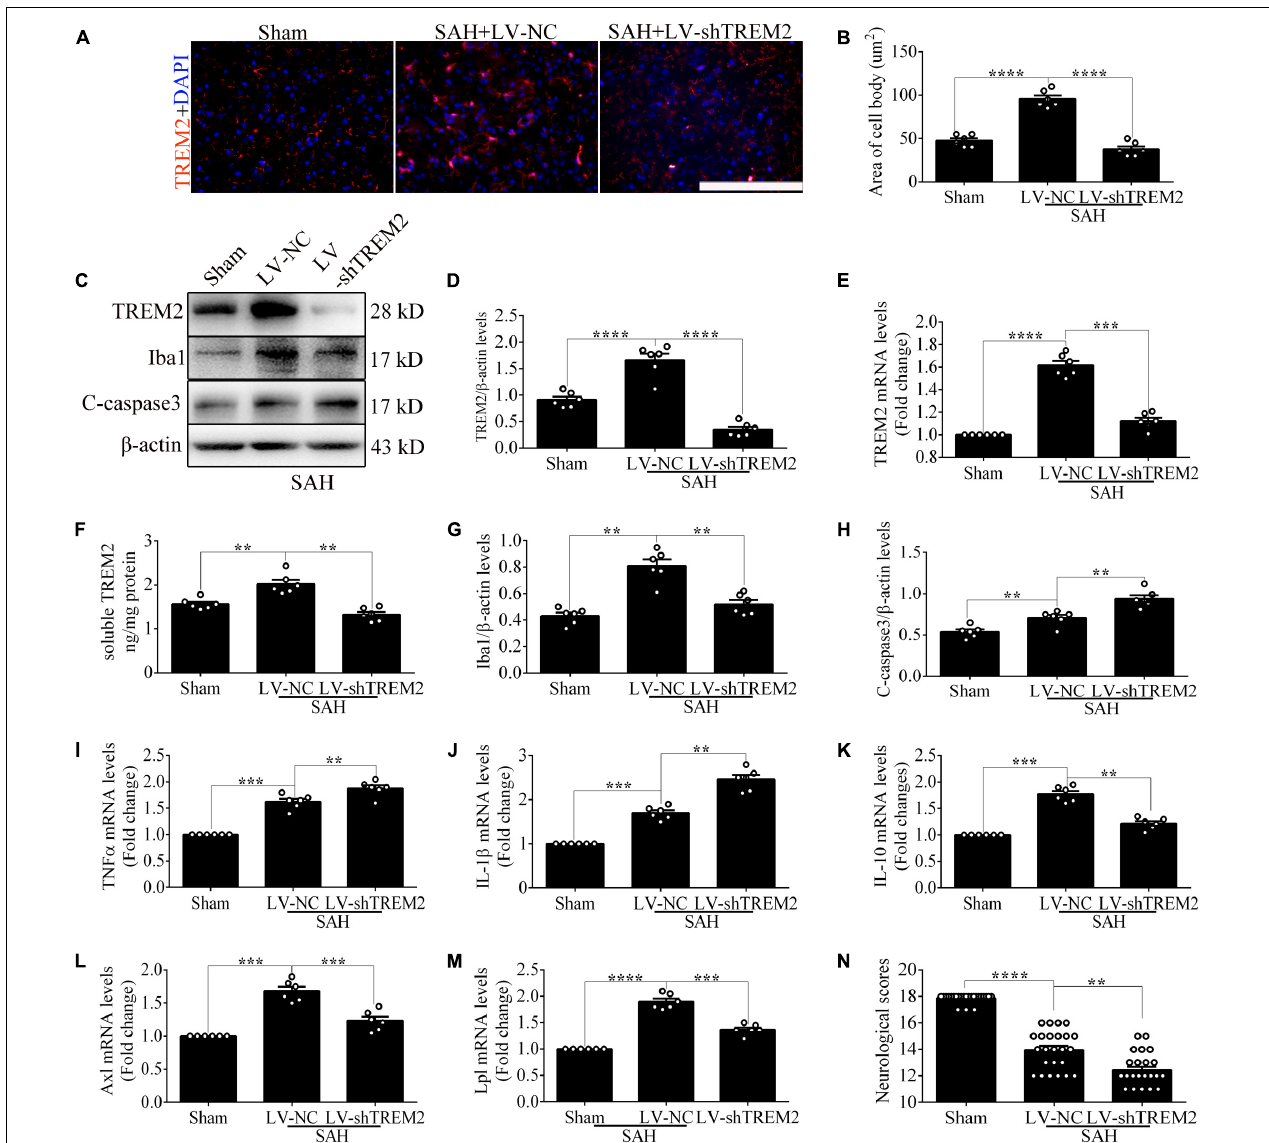
FIGURE 6 | Triggering receptor expressed on myeloid cells 2 ( TREM2 ) silencing regulates microglial polarization at 3 days in vivo after subarachnoid hemorrhage (SAH). (A,B) Immunofluorescence staining and quantitative analysis of the knockdown efficiency of TREM2 in vivo . (C–H) Representative Western blot bands and quantification of TREM2 , soluble TREM2 , TREM2 mRNA, ionized calcium-binding adaptor molecule 1 (Iba1), cleaved caspase-3, and β -actin. (I–M) Quantitative PCR detection revealed the relative mRNA levels of interleukin (IL)-10, tumor necrosis factor (TNF) α , IL-1 β , Axl, and Lpl. (N) Modified Garcia Score System showed the short-term neurological function damage. These data are shown as mean ± SEM ( **p < 0.01, *** p < 0.001, **** p < 0.001).